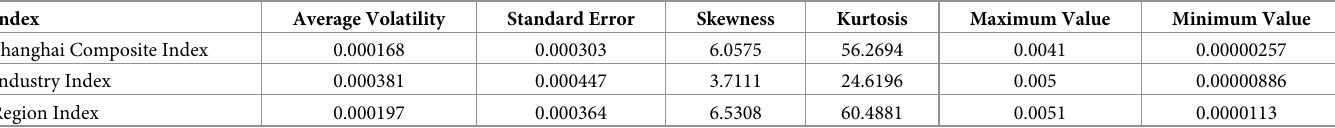
Table 1. Description of indexes’